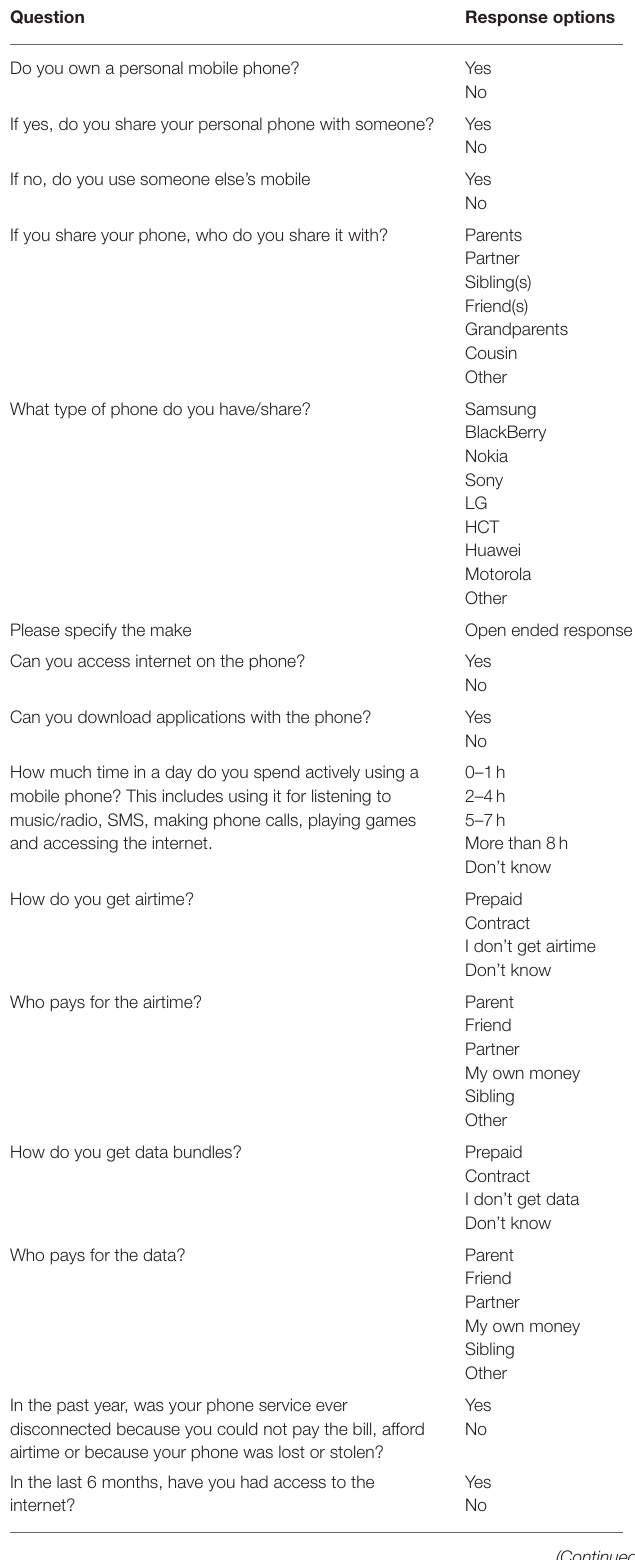
TABLE 2 | Mobile phone use questionnaire. Question Response